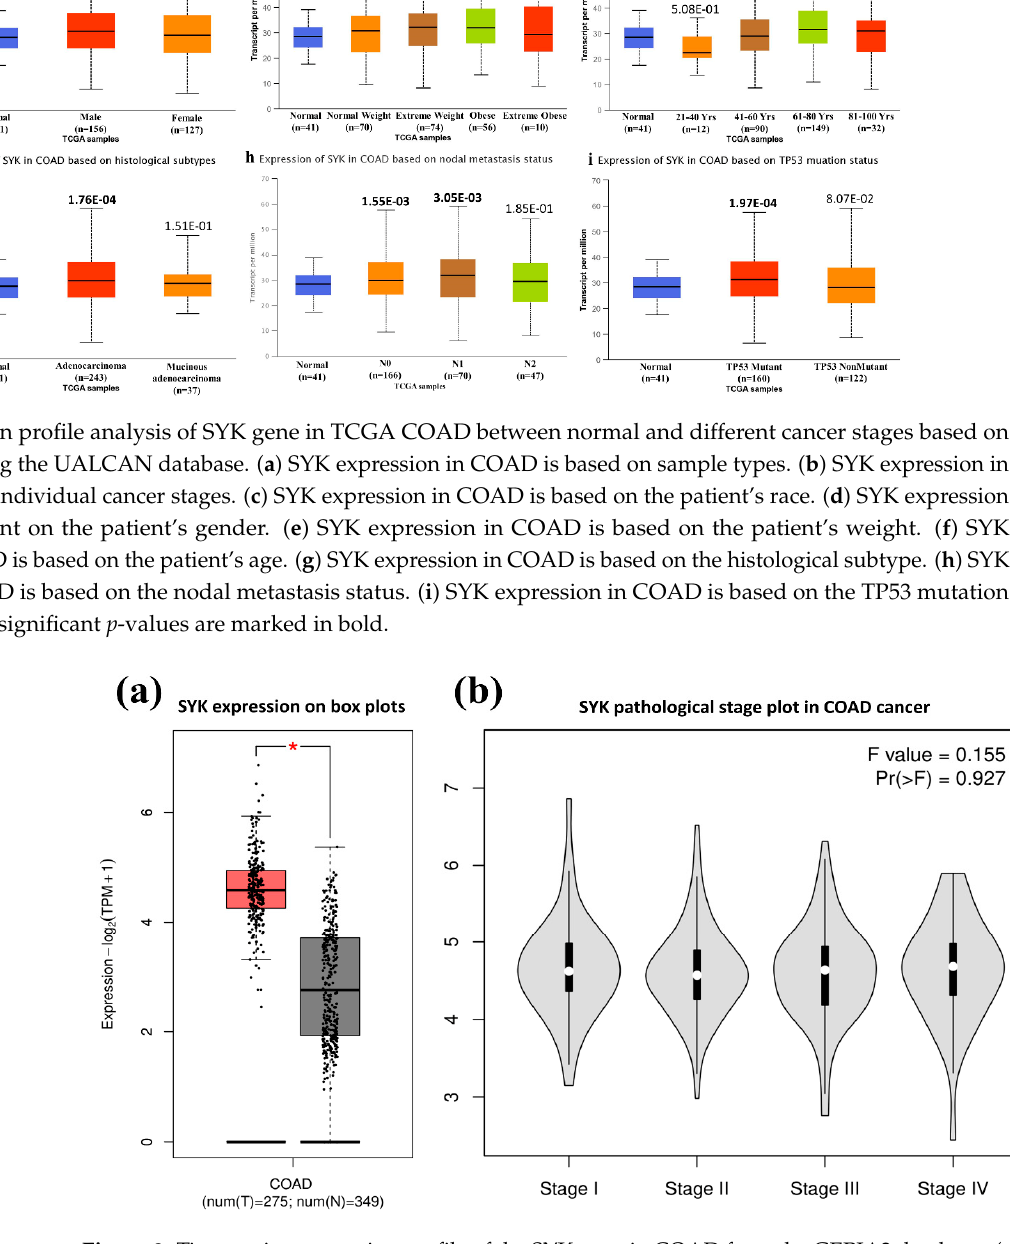
Figure 3. Tissue-wise expression profile of the SYK gene in COAD from the GEPIA2 database. ( a ) The SYK gene expression in COAD on box plots, where the red box indicates the tumor samples, and the black box indicates the normal samples. ( b ) SYK expression in the four tumor stages of COAD on a pathological stage plot. The red star denotes statistical signifi- cance, p -value < 0.05. Similarly, the SYK gene overexpression was also evaluated in the different patholog- ical stages of COAD represented in the violin plot (Figure 3b). The F test value was 0.155, and a probability of the F statistic Pr > F = 0.927. Here, the amount or spread of cancer according to the four cancer stages are depicted in box plots. The wider part in the middle resembles a higher probability of expression around the median value than the skinner part at the end. Apparently, there is no major fluctuation in expression is observed among the four cancer stages. Third, the promoter methylation level of the SYK gene in COAD was determined from the UALCAN database, where the methylation profile is presented on the Beta value scale. The degree of the promoter DNA methylation is shown with a beta value, ranging from 0 (unmethylated) to 1 (completely methylated). The promoter methylation level of the SYK gene was higher in COAD than in normal tissues based on sample types, individual cancer stages, patient’s race, gender, age, and weight, tumor histology, and T53 mutation status. The data on the promoter methylation level of SYK in COAD is presented in Figure 4 and Supplementary Table S3.